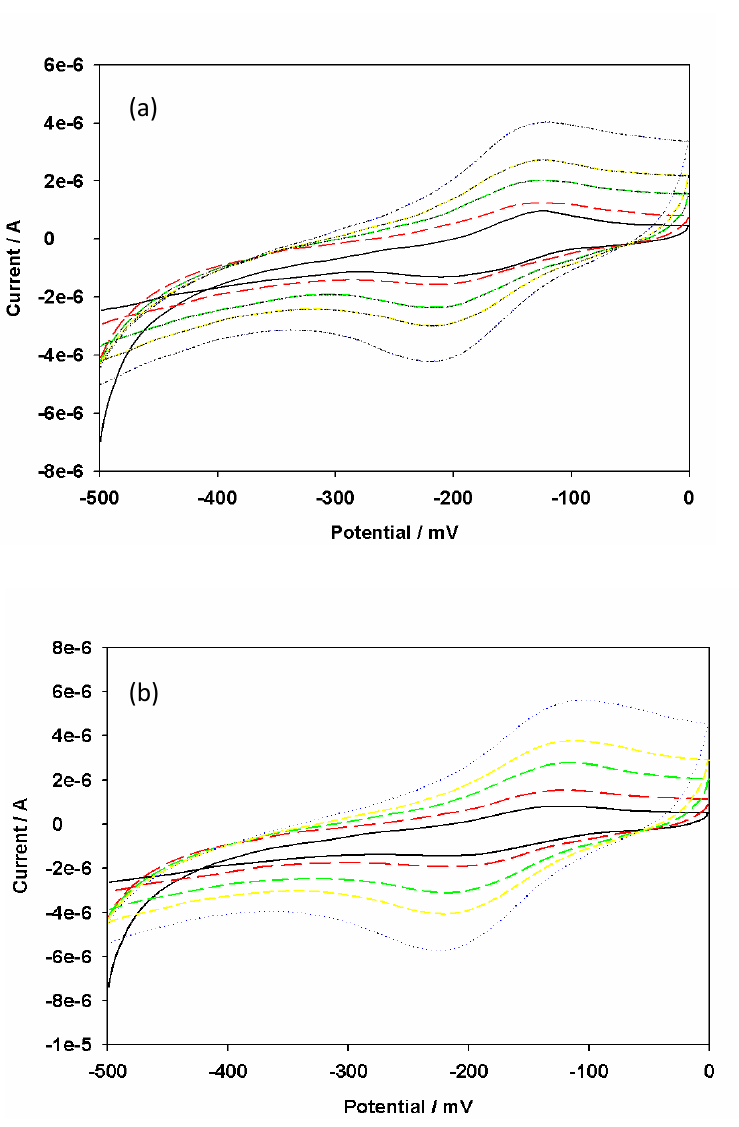
Figure 4. CV’s of (a) PTH|GCE and (b) GCE|PTH|AuNP|AFB buffer (pH 6.5) at 5, 10, 20, 30 and 50 mV/s (starting from the inner